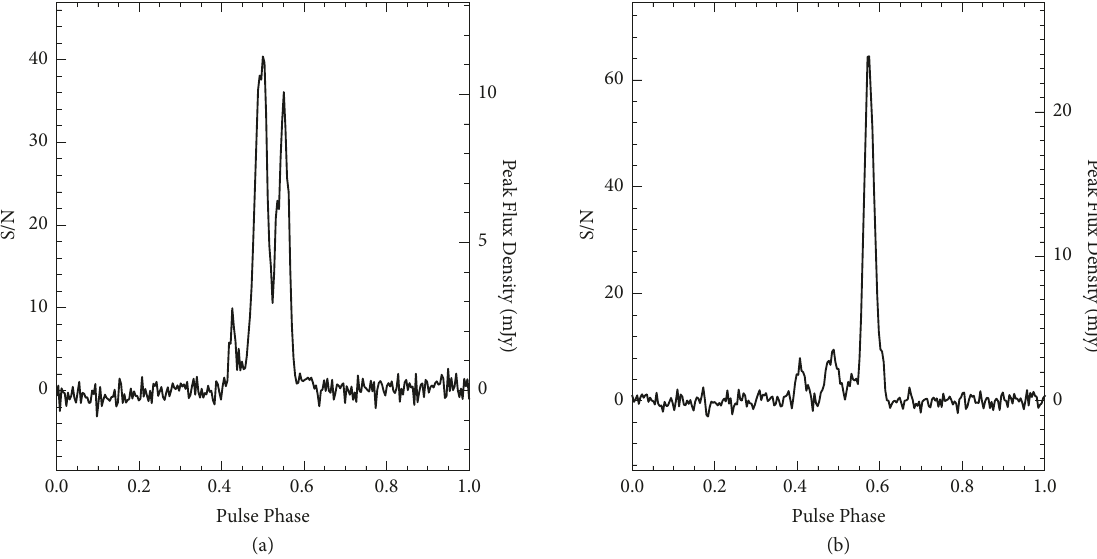
Figure 6: Average 𝑆 -band pulse profiles of PSR J1119–6127, obtained with the 70 m DSN radio telescope (DSS-43) on (a) 2016 August 19 and (b) 2016 September 1, during the pulsar’s recent episode of magnetar-like activity. This figure was adapted from Majid et al. [32]. Additional observations during the pulsar’s post-outburst recovery period will be presented in Pearlman et al.